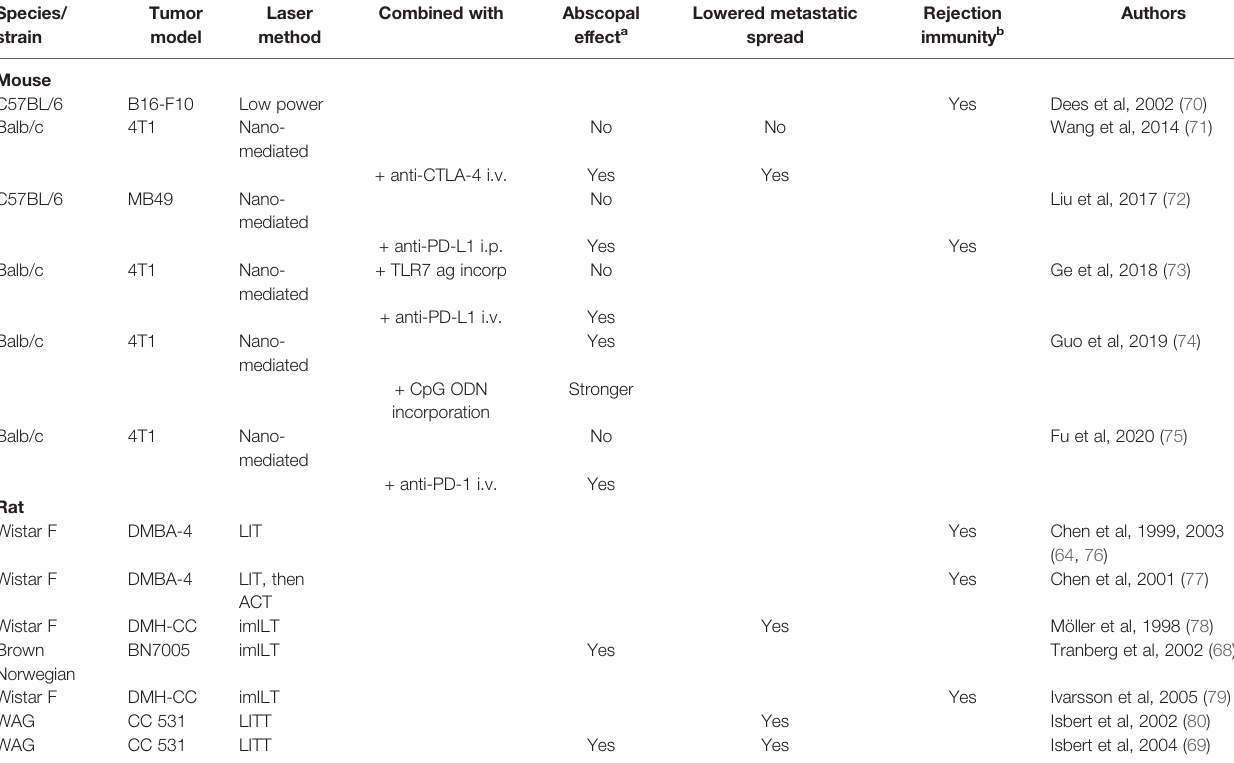
TABLE 2 | Effect on systemic disease after laser-induced thermotherapy in animals. Species/